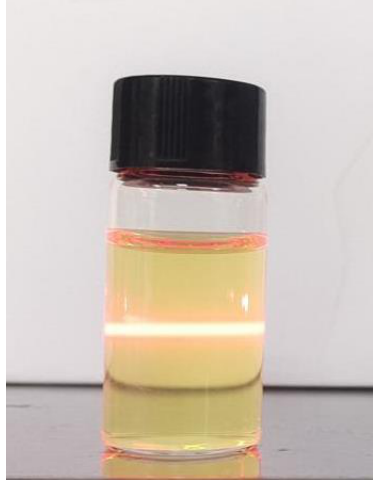
Figure A1. DNC/GA/PVP K30 SD was dissolved in water solution.